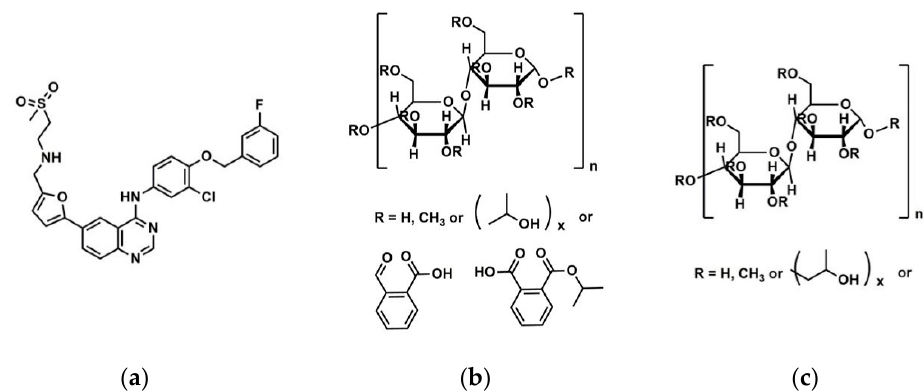
Figure 11. Molecular structures of ( a ) lapatinib (LP) ( b ) hypromellose phthalate (HPMCP) and ( c ) hypromellose (HPMC-E3).